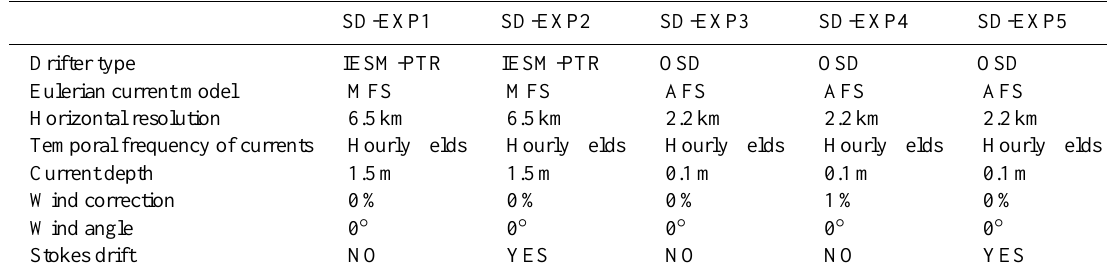
Table 3. Table of experiments designed to study the model’s sensitivity to Stokes drift